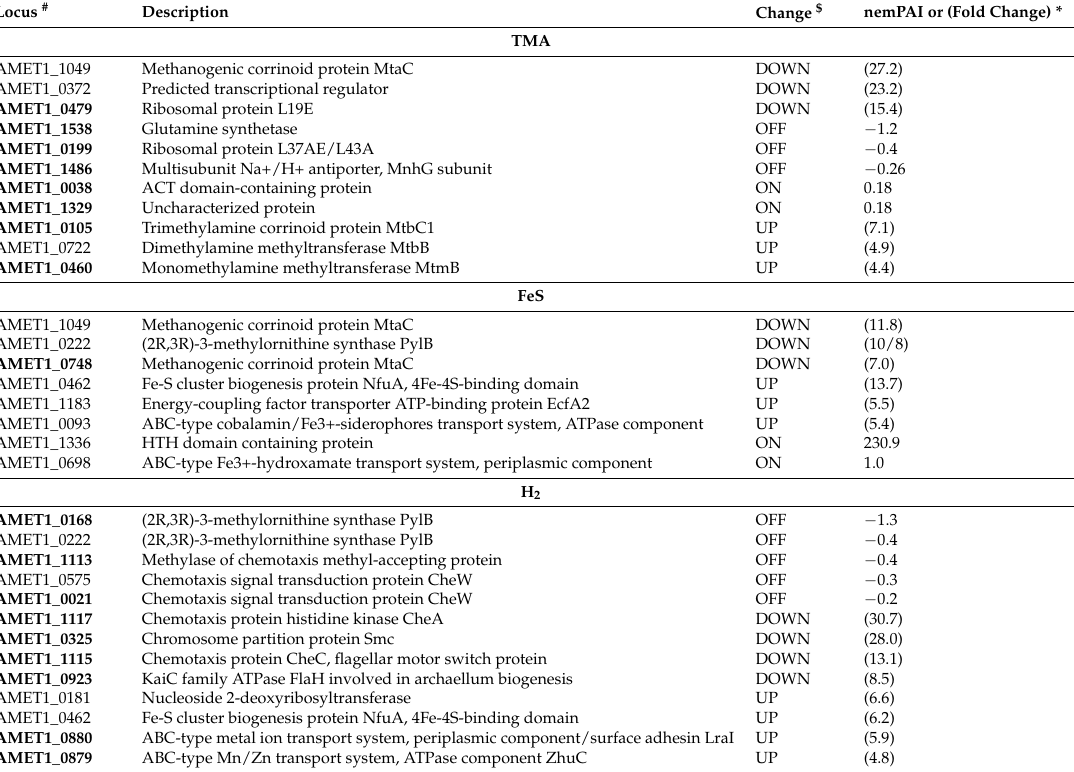
Table 3. Selected proteins involved in growth factor change response in M. thermophilum